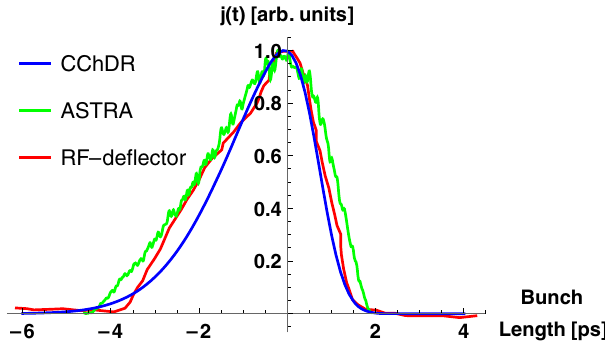
FIG. 10. Skew-Gaussian bunch profile measured with rf-de- flector and CChDR, then simulated by